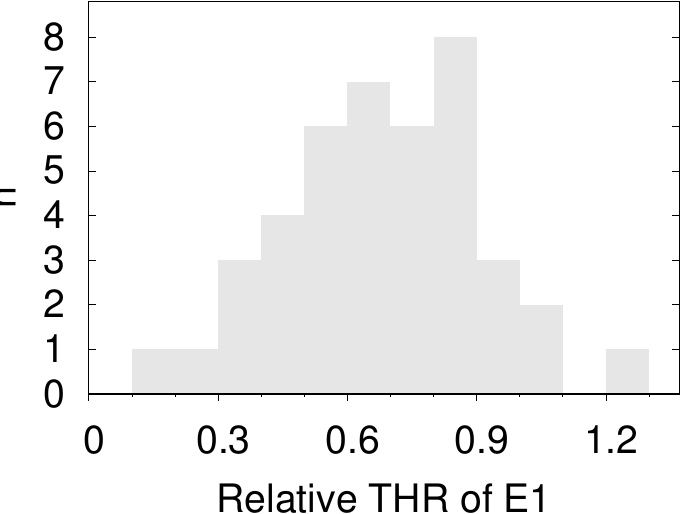
Figure 10. Histogram of the relative position of the THR of the E1s of all donors within the respective interval (cid:104) median of discocytes, largest THR of discocytes (cid:105)